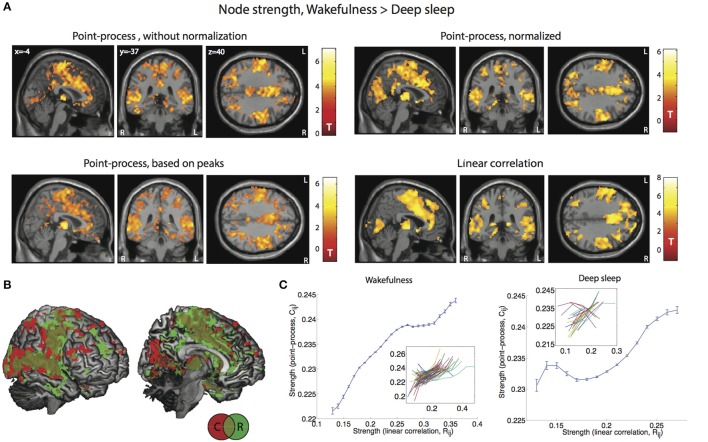
Voxel-wise changes in node strength can be equally observed from Rij and from C˜ij. (A) Spatial maps showing voxels with decreased strength in deep sleep (N3 sleep) vs. wakefulness, both for the point-process analysis (un-normalized and normalized), for the peak-based point-process and for linear correlations (display at p < 0.05, FWE cluster corrected). (B) 3D rendering of the maps in (A): Node strength based on the normalized point-process (red), on linear correlations (green), and their intersection (brown). (C) Plot of the node strength values derived from the point-process vs. those derived from the linear correlation (mean ± SEM), for wakefulness (left) and for deep sleep (right). Insets show the results for individual sleep epochs.